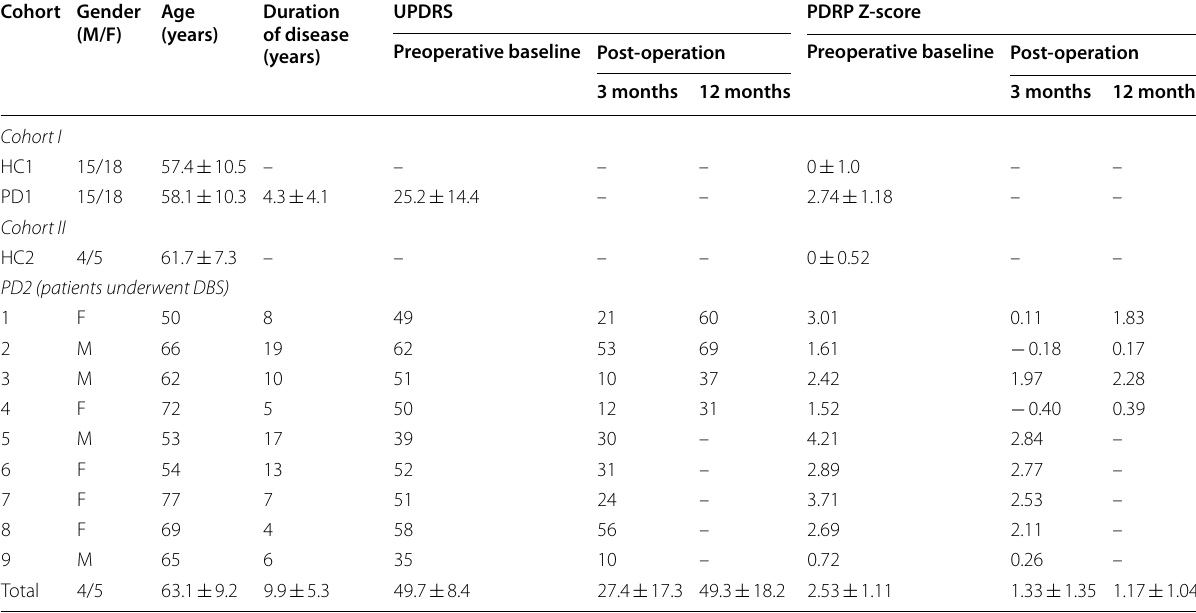
Data are given as mean UPDRS Unified Parkinson’s Disease Rating